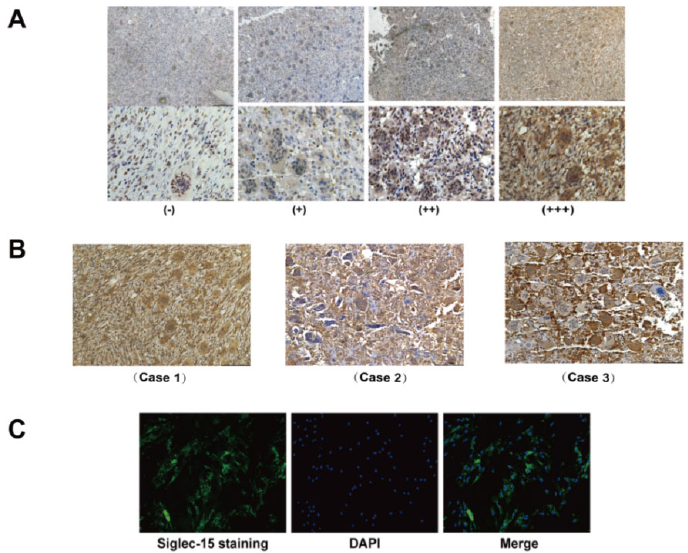
Figure 2. Expression of Siglec-15 in human GCTB tissues and stromal cells. ( A ) Siglec-15 was expressed in the cytoplasm and membrane of GCTB tissues as shown by immunohistochemistry assay. ( B ) Expression of Siglec-5 in recurrent GCTB cases. Case 1: recurrence once, Case 2: recurrence twice, and Case 3: recurrence three times. ( C ) Siglec-15 protein expression in the cytoplasm and membrane of GCTB stromal cells as shown by immunofluorescence assay. Scale bars, 200 µ m and 400 µ m.